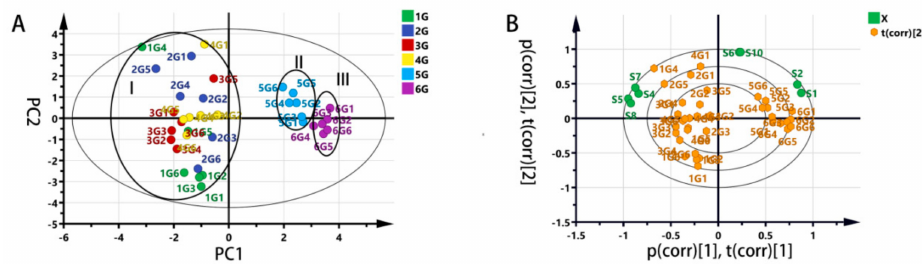
Figure 5. Principal component analysis (PCA) of jasmine tea samples. ( A ) PCA scores scatter plot with Pareto scaling mode (R2X [1] = 0.599 and R2X [2] = 0.331); ( B ) Biplot of ten sensors and standard jasmine tea samples with Pareto scaling